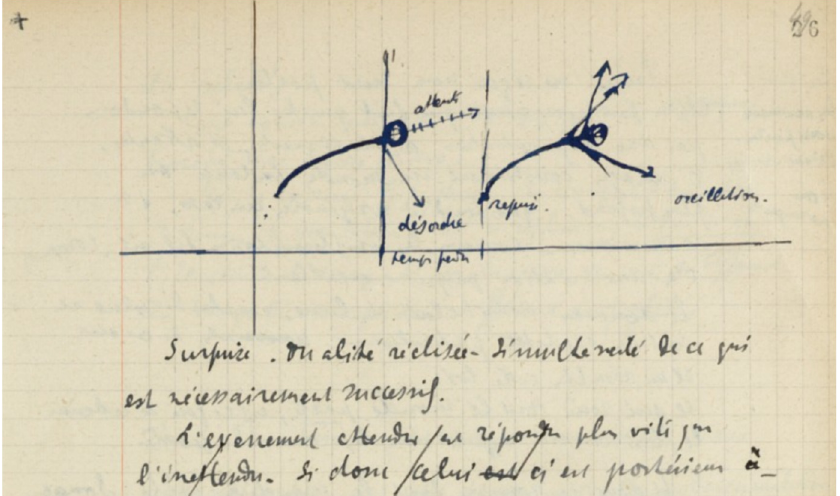
Figure 1. An example of the temporal notation of surprise from Cahiers.